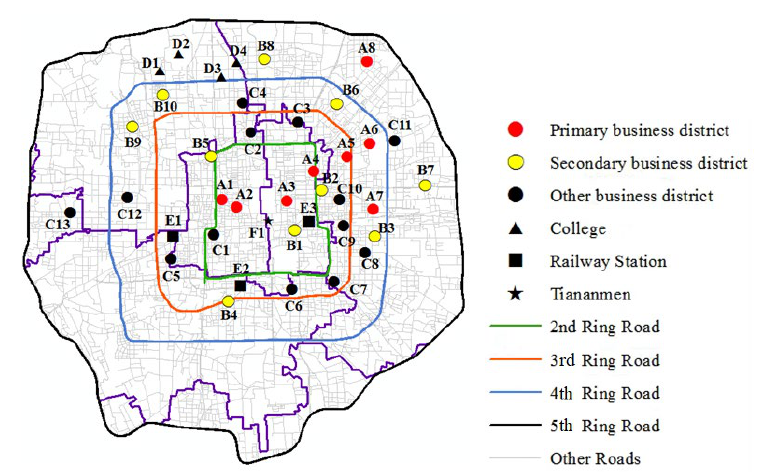
Figure 1. Overview of the study area.